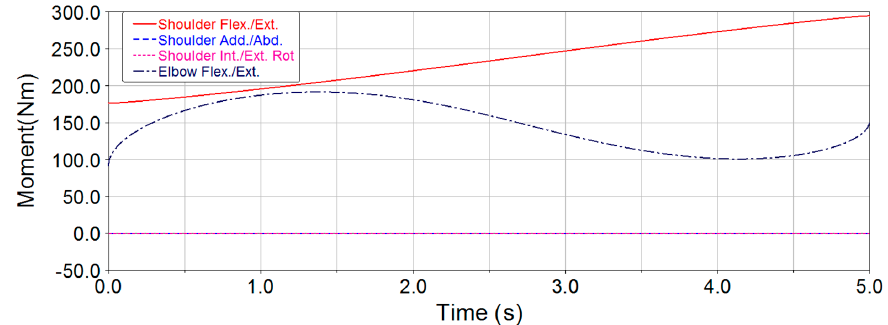
Figure 11. Joint torque curves of raising up for the 5 ‐ DOF exoskeleton.